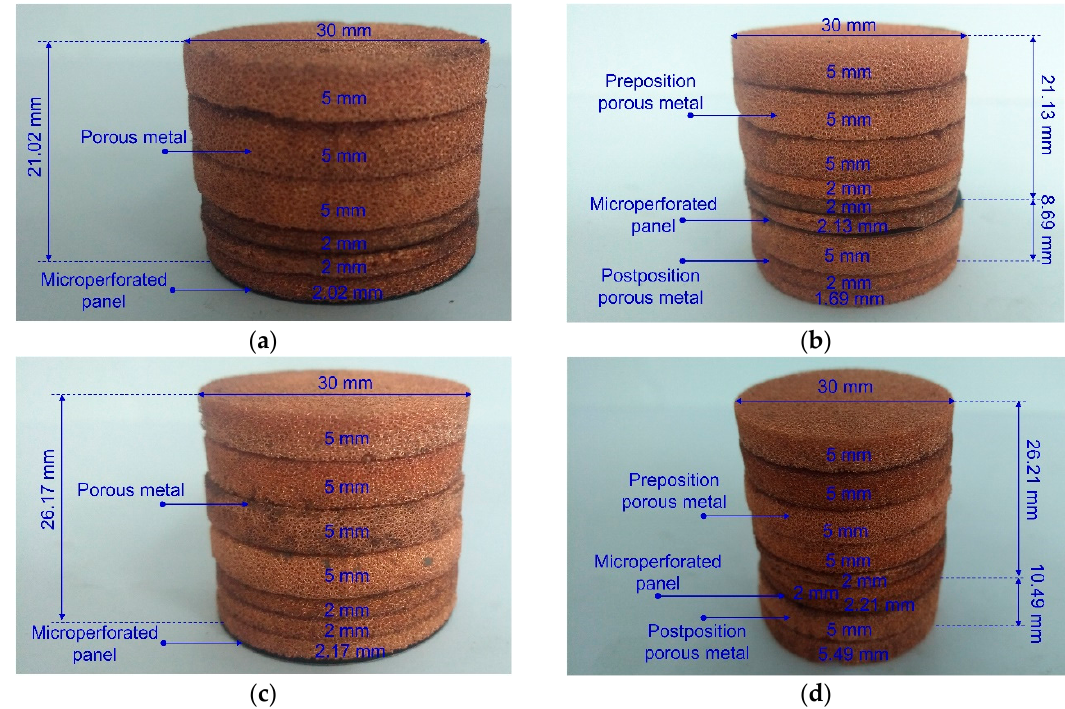
Figure 8. The prepared optimal composite structures. ( a ) Optimal PCMC with limited total thickness of 30 mm; ( b ) optimal PCMCPC with limited total thickness of 30 mm; ( c ) optimal PCMC with limited total thickness of 50 mm; ( d ) optimal PCMCPC with limited total thickness of 50 mm.